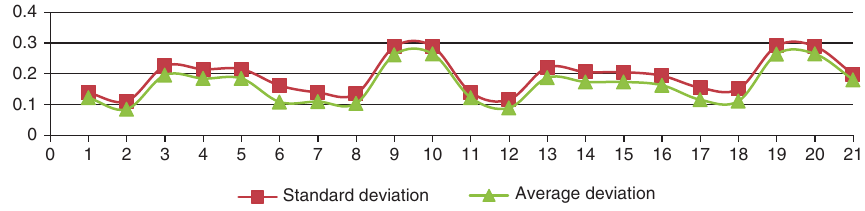
Figure 6: Standard/Average Deviation Results for Proposed 21 Measures on Score Classes 3–4 with MSR Paraphrase.